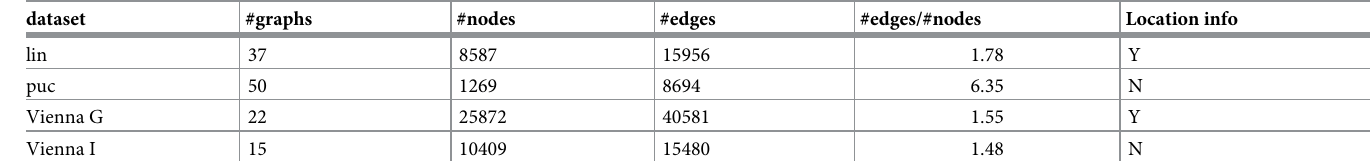
Table 1. Dataset descriptions; all numbers are averages over all the graphs in a dataset. # x represents the number of elements in x .